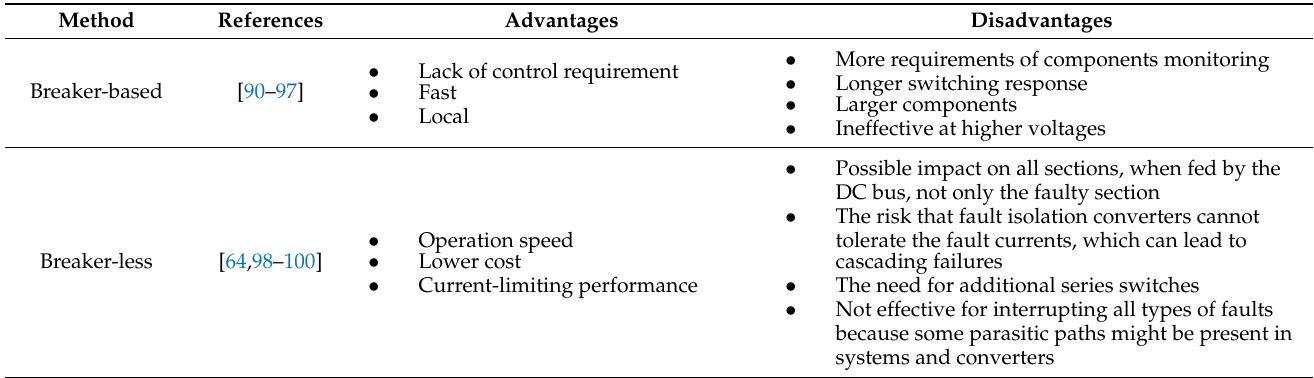
Table 5. Summary of fault isolation